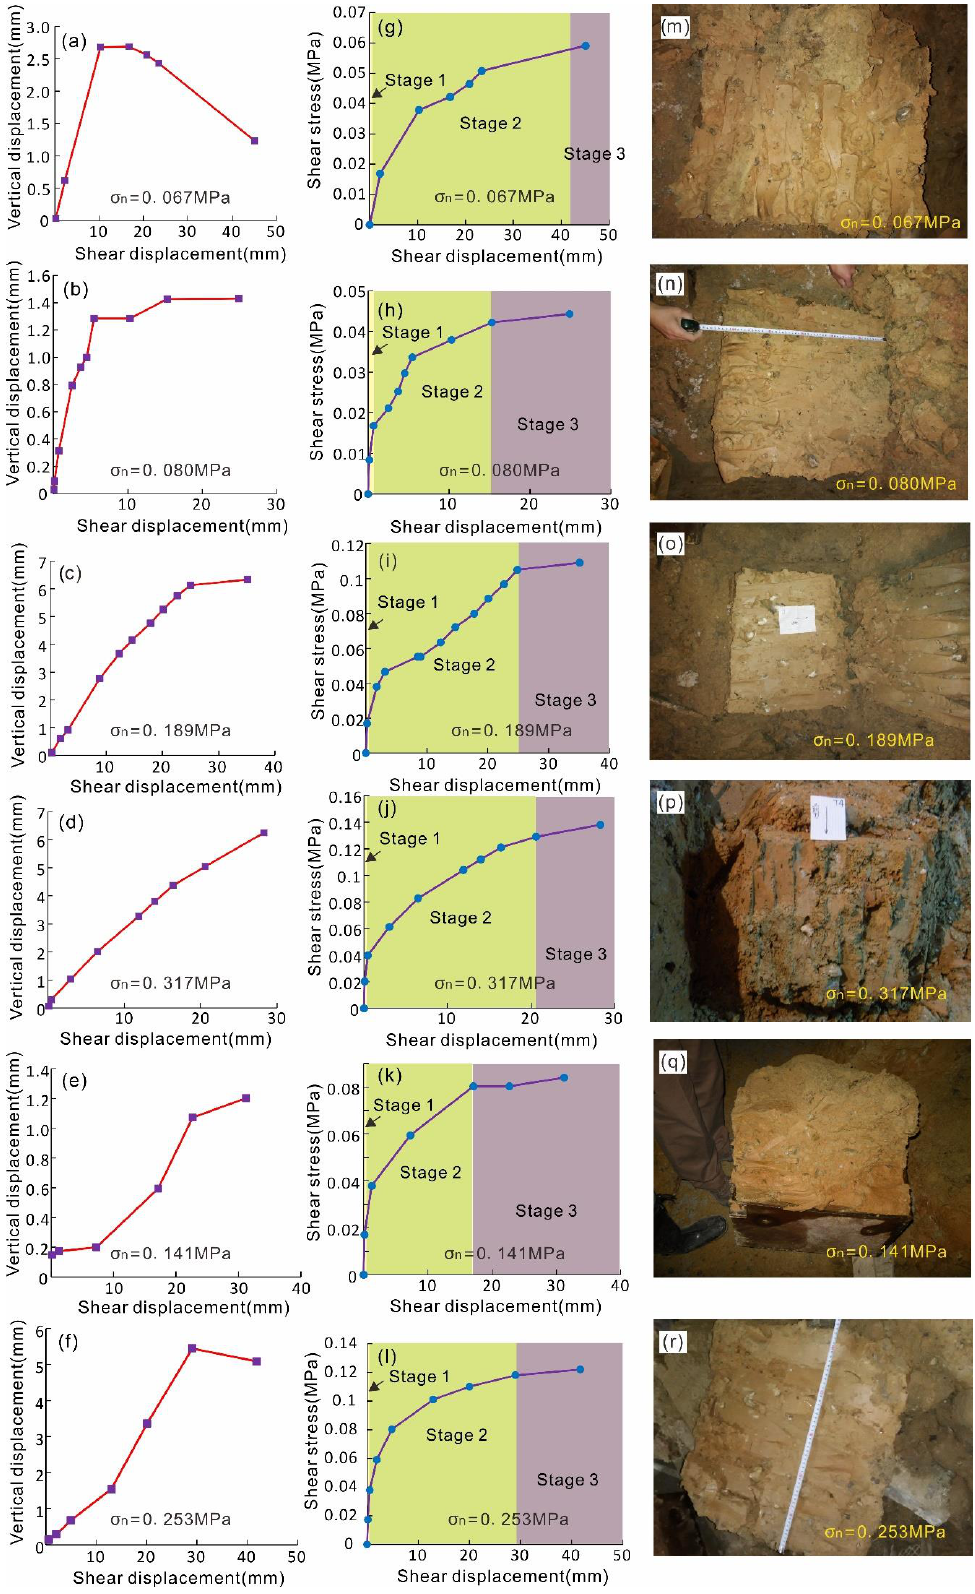
Figure 8. ( a – f ) Shear stress with the increase of shear displacement under various normal stress conditions. ( g – l ) Normal displacement of the samples with the increase of the shear displacement under various normal stress conditions. ( m – r ) Shear plane surface of the samples after the shear